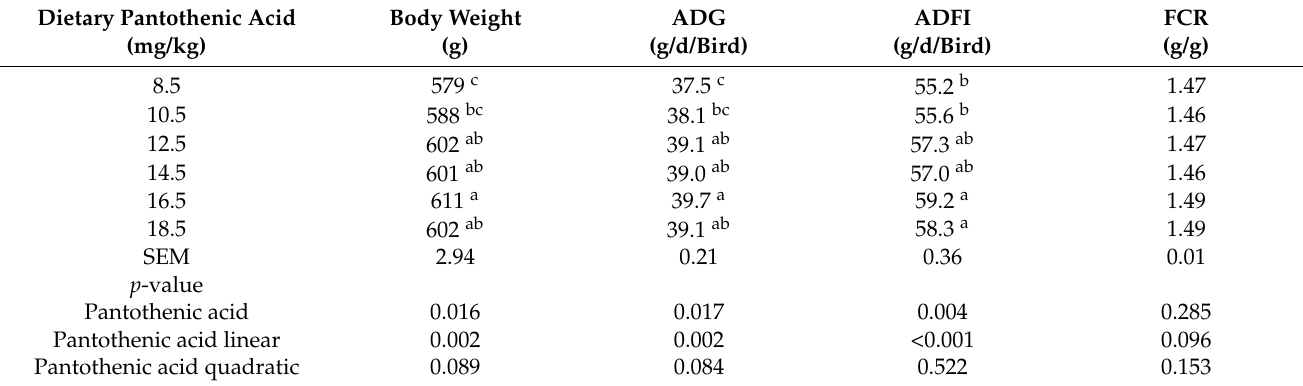
Table 2. Effect of dietary pantothenic acid levels on growth performance of male white Pekin ducks from hatch to 14 days of age 1